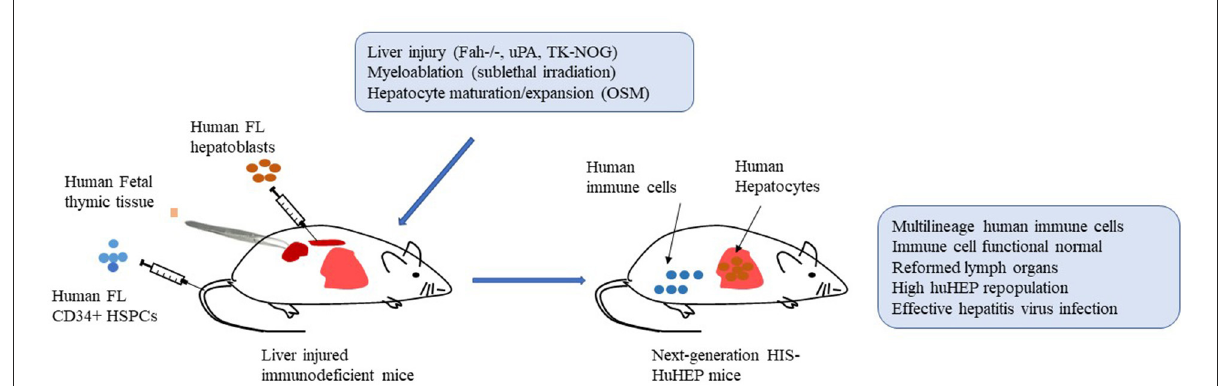
FIGURE1 Establishment of next-generation humanized mice with both functional human immune systems and autologous hepatocytes (HIS-HuHEP mice). Autologous human fetal liver CD34 + hematopoietic stem/progenitor cells (HSPCs; intravenously), fetal hepatoblasts (intrasplenic), and fetal thymic tissues (under kidney capsule) are transplanted into immunodeficient mice with gene modifications of liver injury, such as Fah-/-Rag2-/-IL2rg-/- (FRG mice), SCID mice expressing uroplasminogen activator (uPA) in liver (uPA/SCID mice), and NOG mice expressing a herpes simplex virus type 1 thymidine kinase (HSVtk) in liver (TK-NOG mice). Sublethal irradiation is used to promote bone marrow engraftment of HSPCs. Liver injury caused by indicated gene modification and human Oncostatin M (OSM) treatment improve the liver repopulation with human fetal hepatoblasts. More importantly, human T cells are developing in human thymic tissue. Overall, the resultant HIS-HuHEP mice display improved reconstitution levels and functions of human immune cells, the formation of lymph organs such as spleen and lymph nodes, high-level repopulation of human hepatocytes, and highly effective infection with Hepatitis B virus (HBV) or Hepatitis C virus